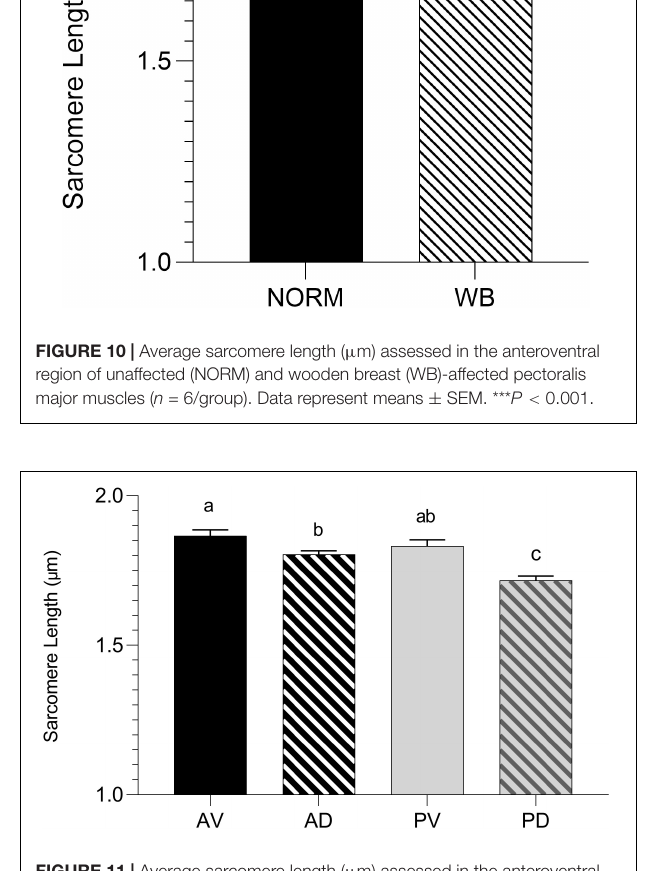
FIGURE 11 | Average sarcomere length ( µ m) assessed in the anteroventral (AV), anterodorsal (AD), posteroventral (PV), and posterodorsal (PD) positions of pectoralis major muscles affected by WB myopathy ( n = 6/position). Data represent means ± SEM. (a–c) Means lacking a common letter significantly differ ( P <